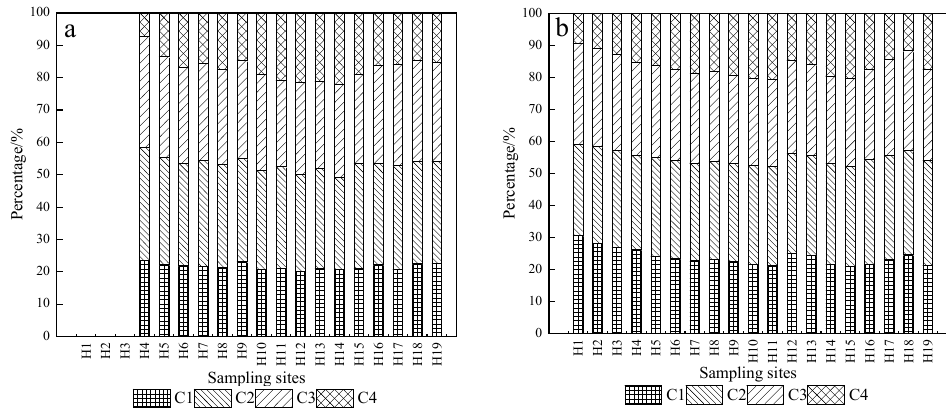
Figure 5. Percentages of four fluorescent components: ( a ) Dry season; ( b ) Wet season.